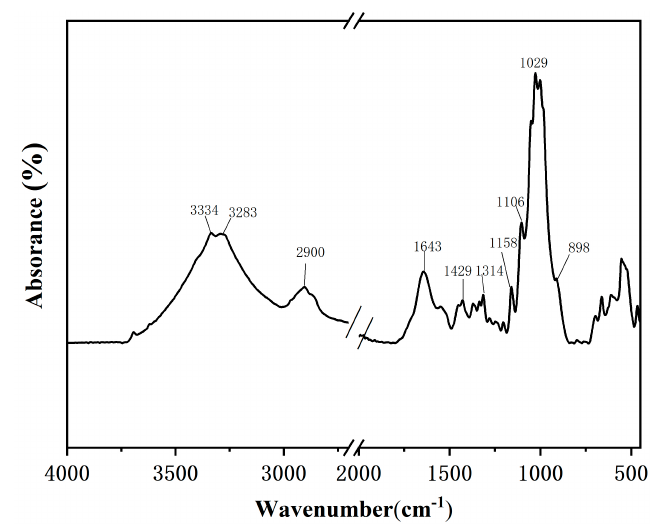
Figure 4. FT-IR spectrum of a fiber sample.